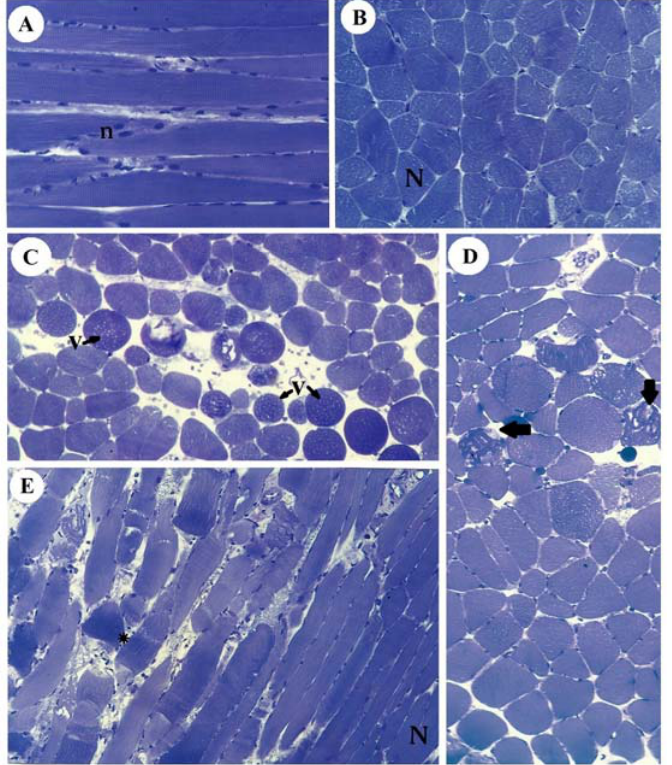
Figure 6. Light micrographs of PND incubated with Tyrode show normal fibers (N) with their well-positioned nuclei (n) (A: longitudinal section, B: transversal section) and of SOL (C), EDL (D) and PND (E) showing different stages of cellular disorganization after incubation with 10 mM guanidine for 60 min, under indirect electrical stimulation; altered cells show vacuolation (V), worm-like threads of myofibrils interspersed among empty- looking regions of sarcoplasm due to sarcolemma disruption (arrows) or hypercontraction caused by densely packed myofibrils (*). See also edematous (round in shape) and non-homogeneously stained myofibers (toluidine blue). Bar: 35